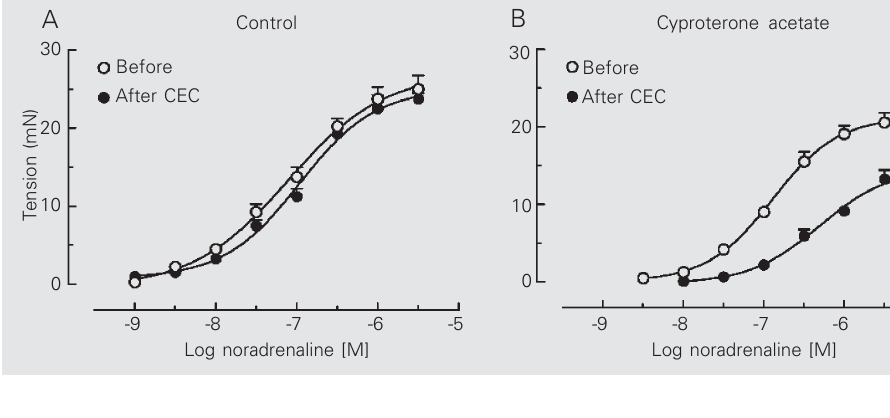
B. After CEC C. Schild plot